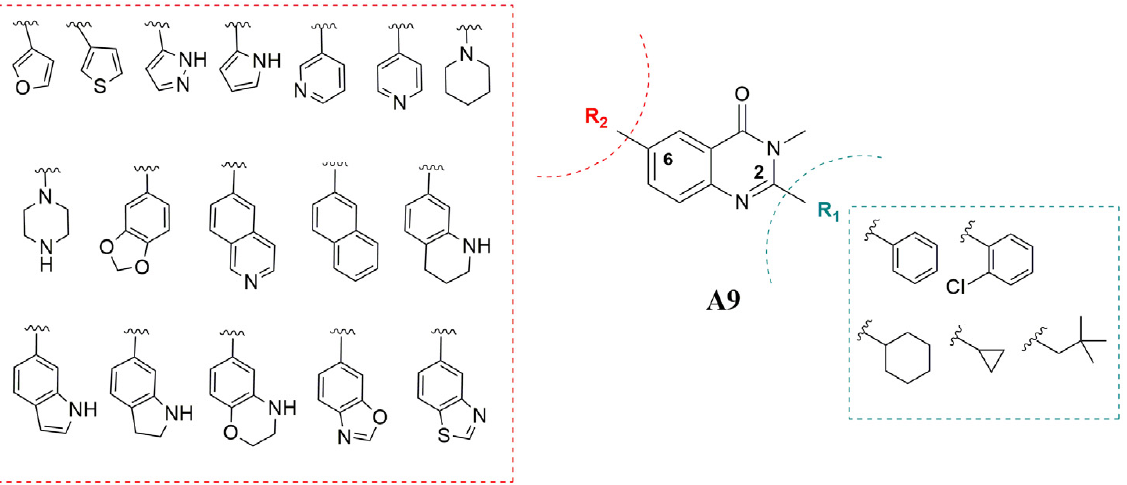
Figure 6. Structural modifications explored for the A9 chemotype at the C-2 and C-6 positions. All analogs (depicted in Table S1, Supplementary Materials) were inactive as mGlu 7 NAMs (IC 50s > 10 µM).